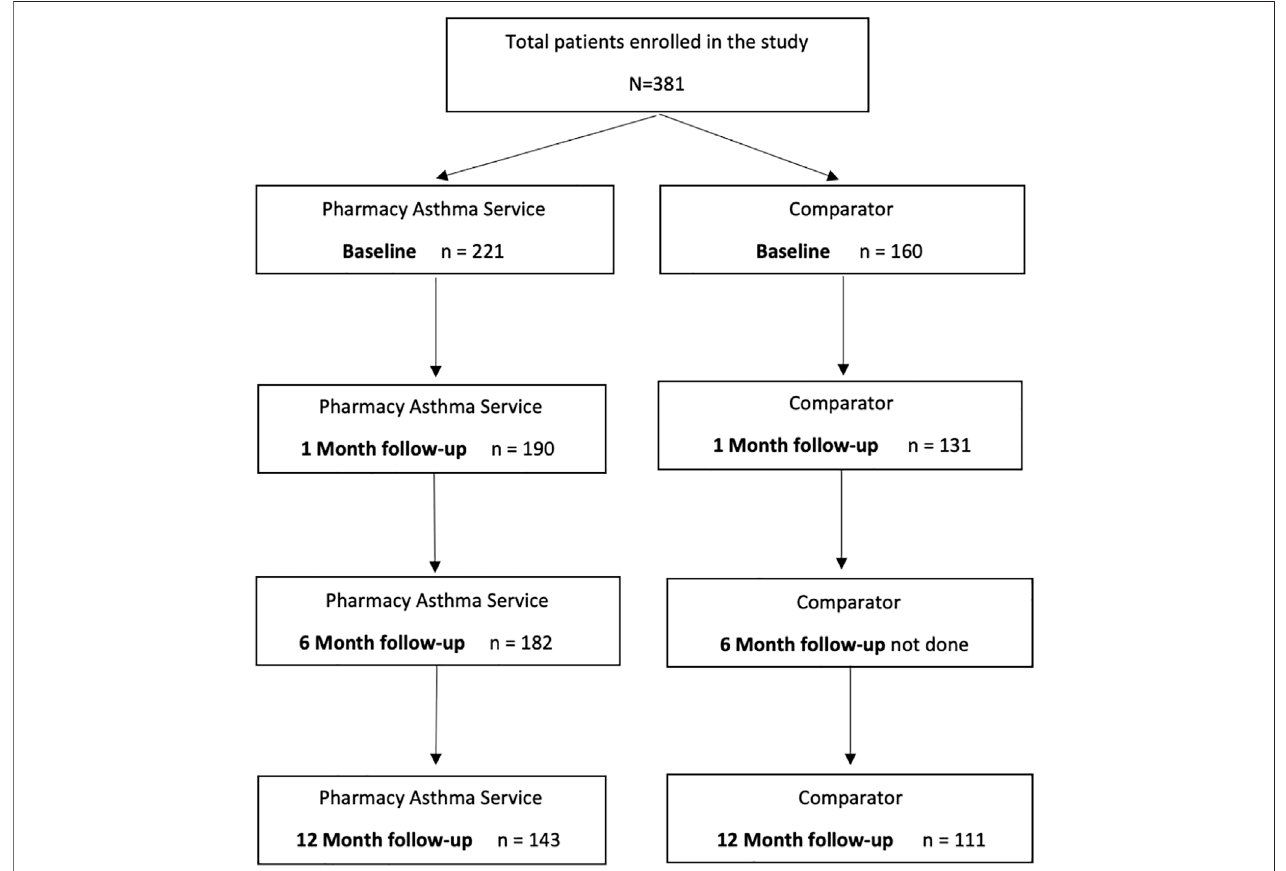
FIGURE 2 | Patient Consort